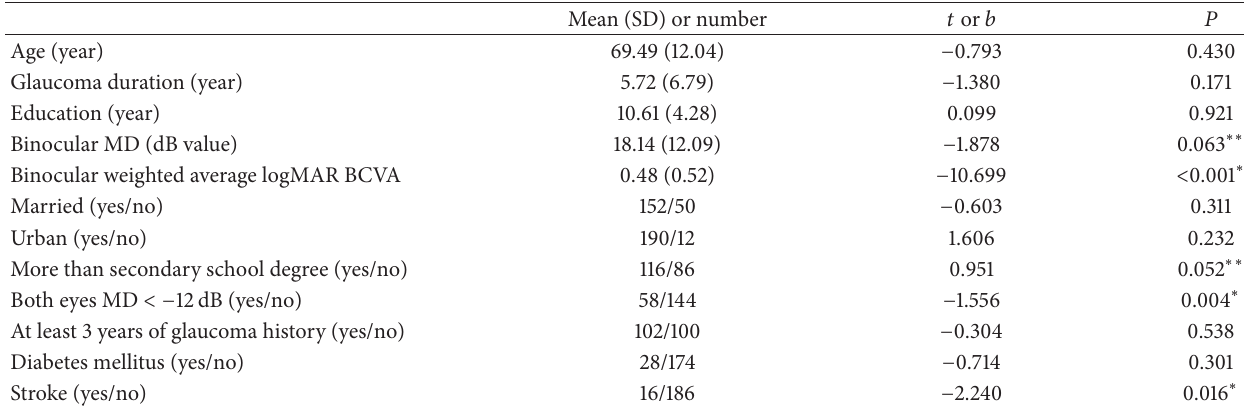
Table 5: Multiple impact factors that influence VRQOL score of glaucoma